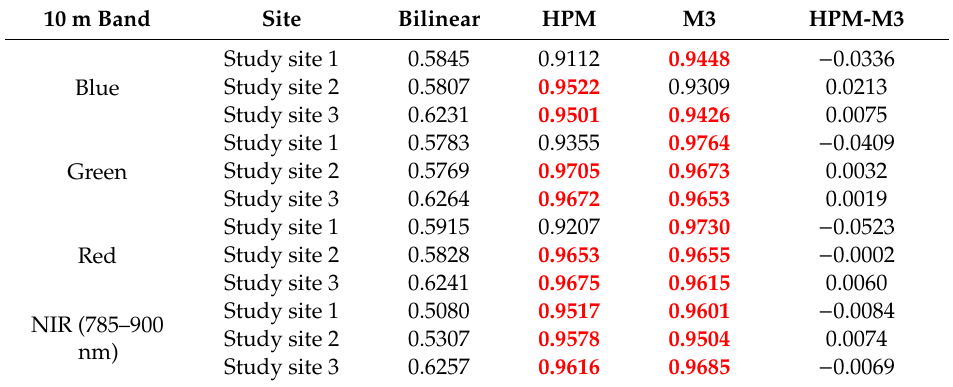
Table 4. Study site Q 2 n values derived considering the four Sentinel-2 10 m sharpened bands independently ( n = 1). The highest Q 2 n value (least distortion) for each study site is shown in red bold font, and if values are within two decimal places (i.e., | HPM-M3 | < 0.01), then both are shown in red